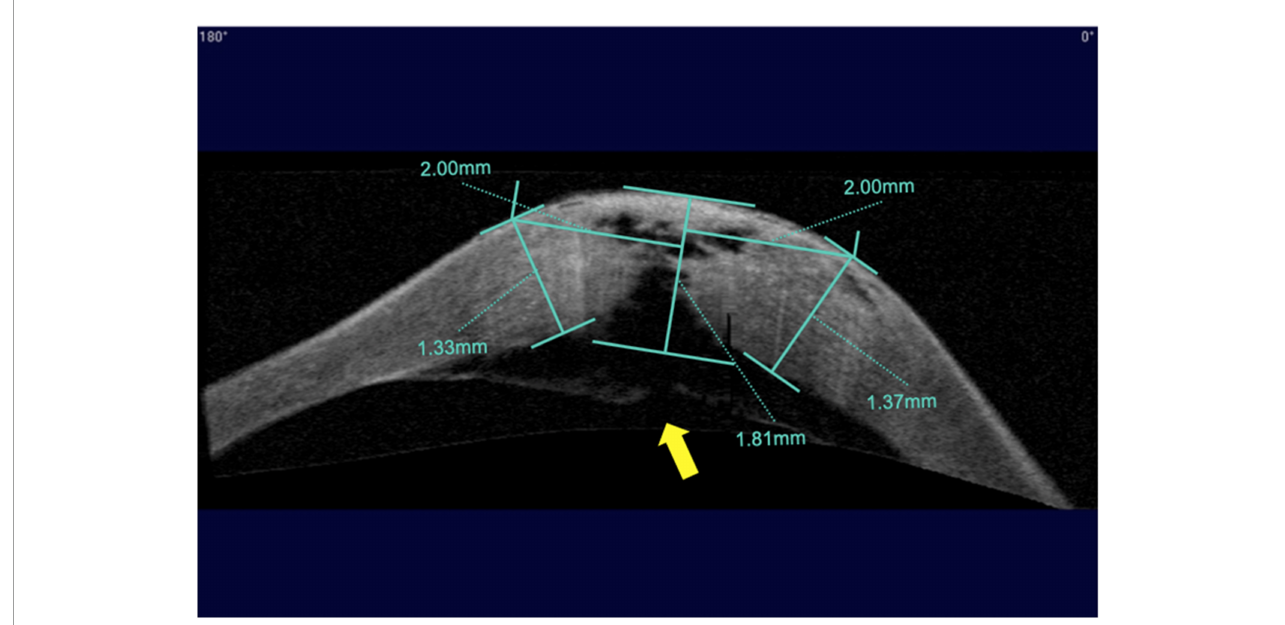
FIGURE2 Measurement of corneal thickness using anterior segment optical coherence tomography (AS–OCT) after acute corneal hydrops. Indicated from left to right are the corneal thickness 2 mm nasal to the corneal apex with a horizontal scan, the corneal thickness at the apex, and the corneal thickness 2 mm temporal to the corneal apex with a horizontal scan. The yellow arrow indicates a break in Descemet’s membrane.